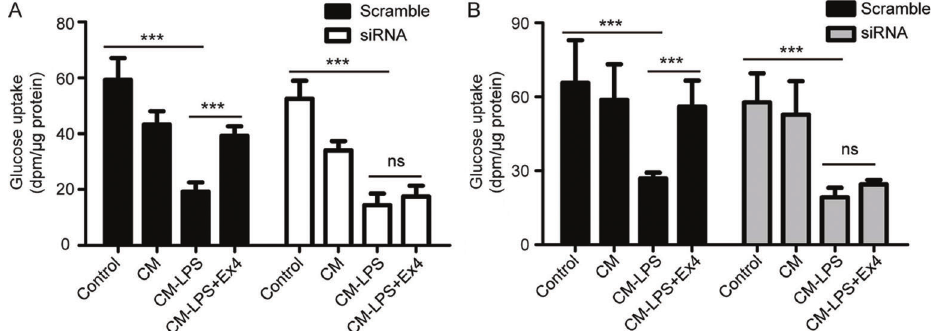
Figure 4. Effect of exendin-4 (Ex4)-treated macrophage conditioned media (CM) on insulin-stimulated glucose uptake. 3T3-L1 adipocytes were untreated (control group) or treated with CM, CM-lipopolysaccharide (LPS), or CM-LPS-Ex4 from RAW264 cells ( A ) or mouse peritoneal macrophages ( B ). The results are representative of three independent experiments. Data are reported as means ± SD. ***P o 0.001 (ANOVA). ns: non-signi fi